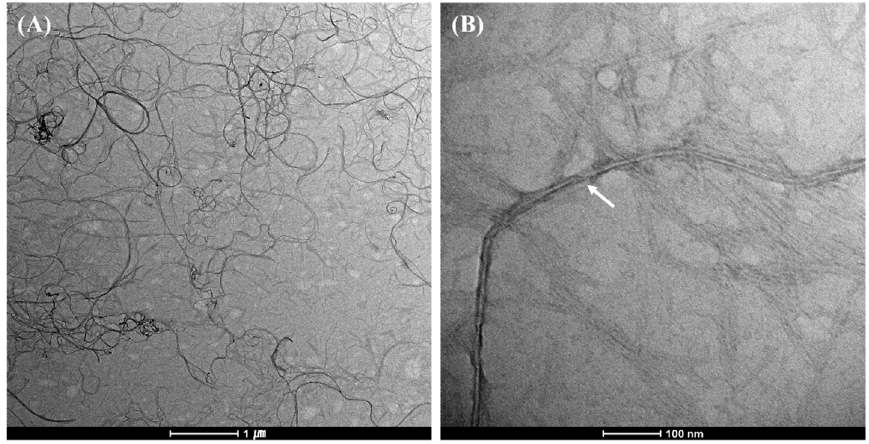
Figure 3. TEM images of RCNT-CNC with marked by arrow the raw MWCNTs ( A ) 1500×, ( B ) 20000×.